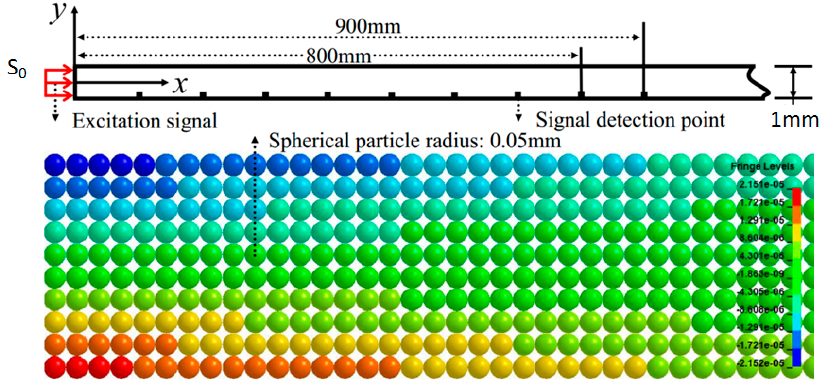
Figure 3. Meshless Local Petrov-Galerkin-Eshelby Method (MLPGEM) model.